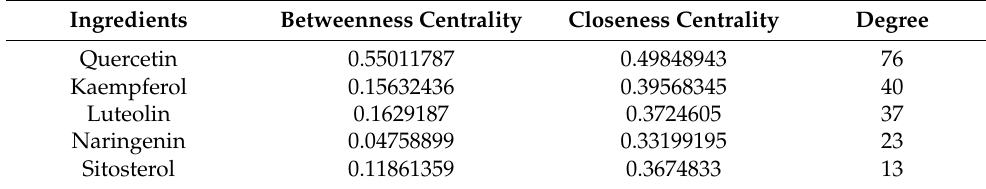
Table 2. Key molecules and topological parameters of RSBDP against IBD (Top 5).